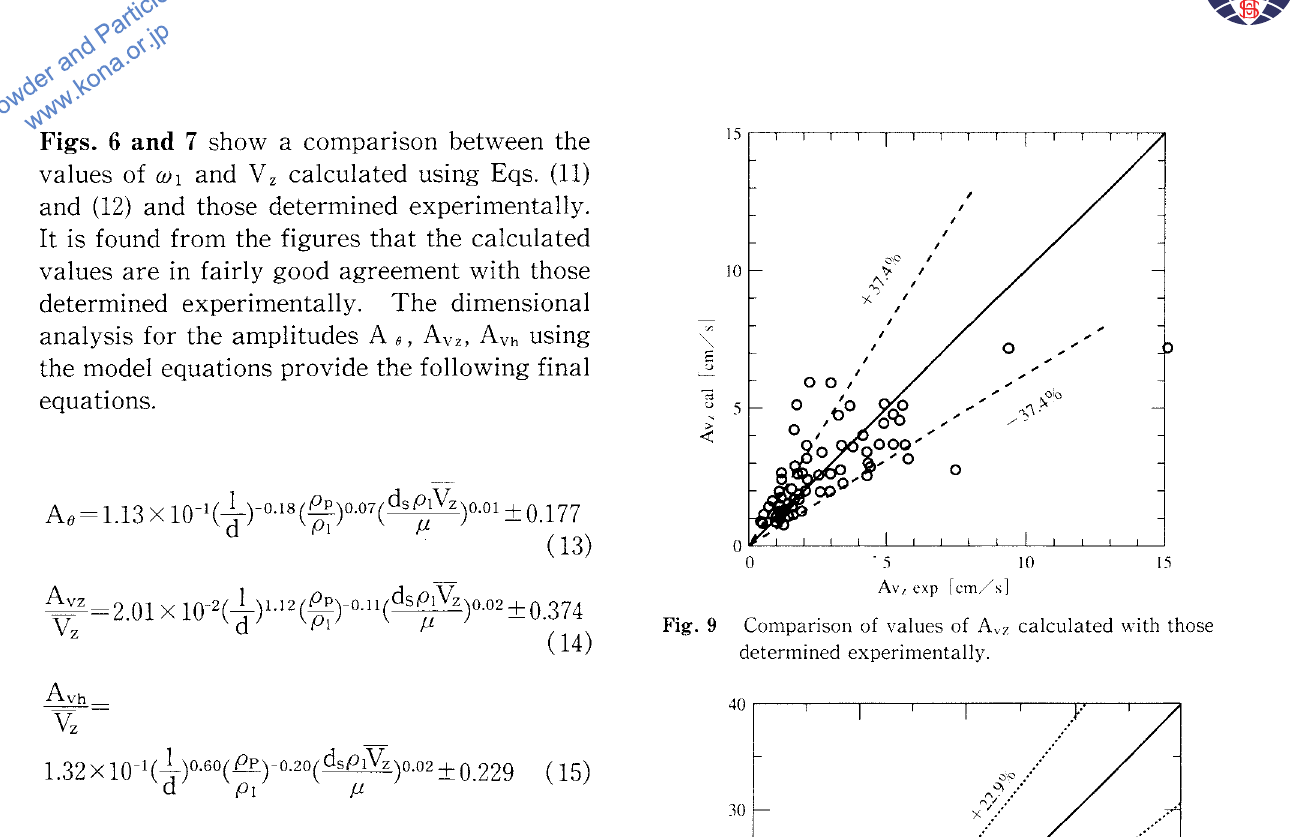
Fig. 9 Comparison of values of A,z calculated with those determined experimentally.